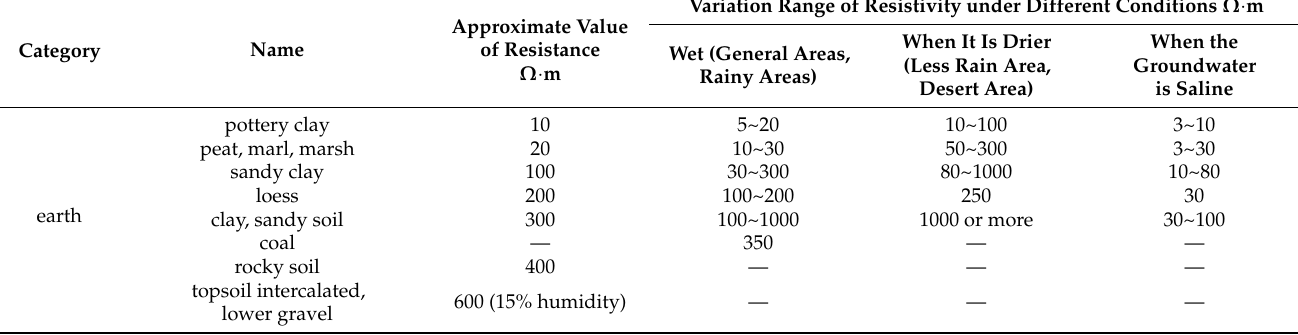
Table 2. Resistivity of different media.